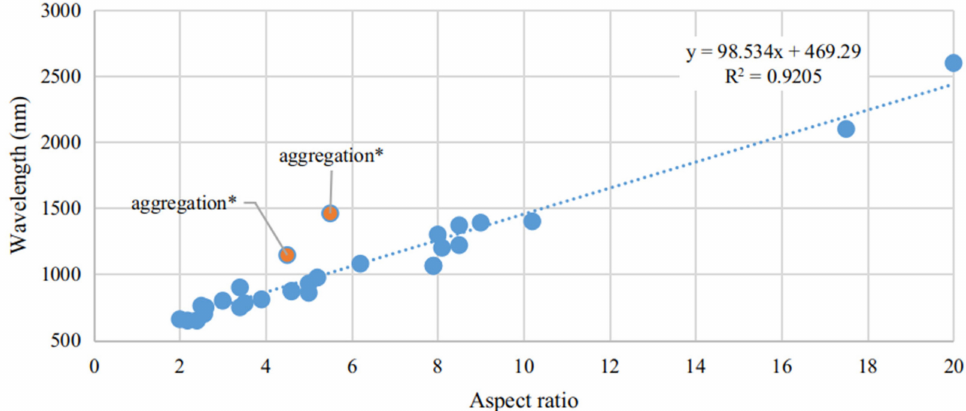
Figure 7. Longitudinal LSPR mode wavelength dependency on aspect ratio for Au NRs. Two data points are highlighted at a different color due to the displacement caused by aggregation